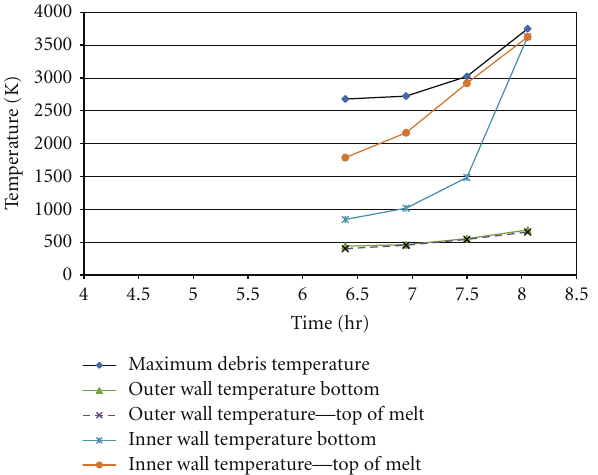
Figure 18: Temperatures in lower plenum wall and debris after melt relocation for a scenario with depressurization and termination of emergency water injection at 4.2 hours after reactor scram (CRD flows